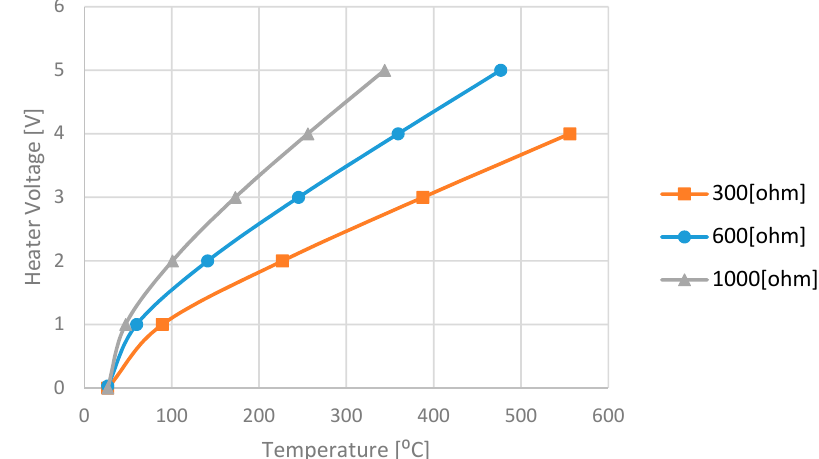
Figure 9. The hot-plate simulation results: applied heater voltage vs. the steady-state average hot plate temperature for different R heater values.